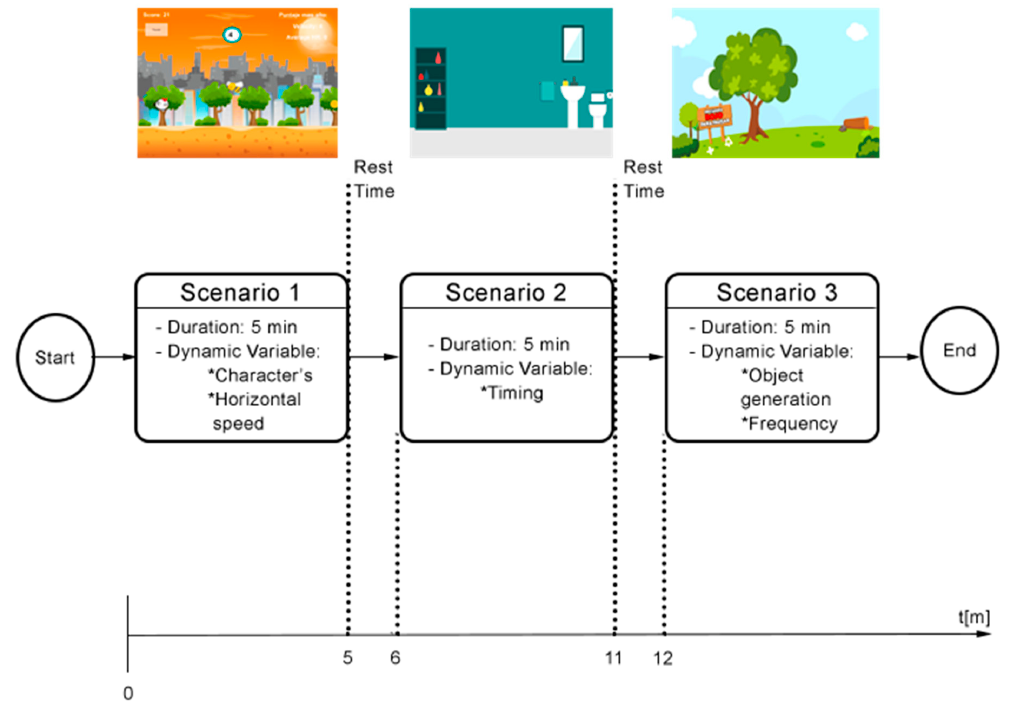
Figure 1. General description of PetsGo scenarios. Scenario 1 (bird). Scenario 2 (bathtub). Scenario 3 (tree).